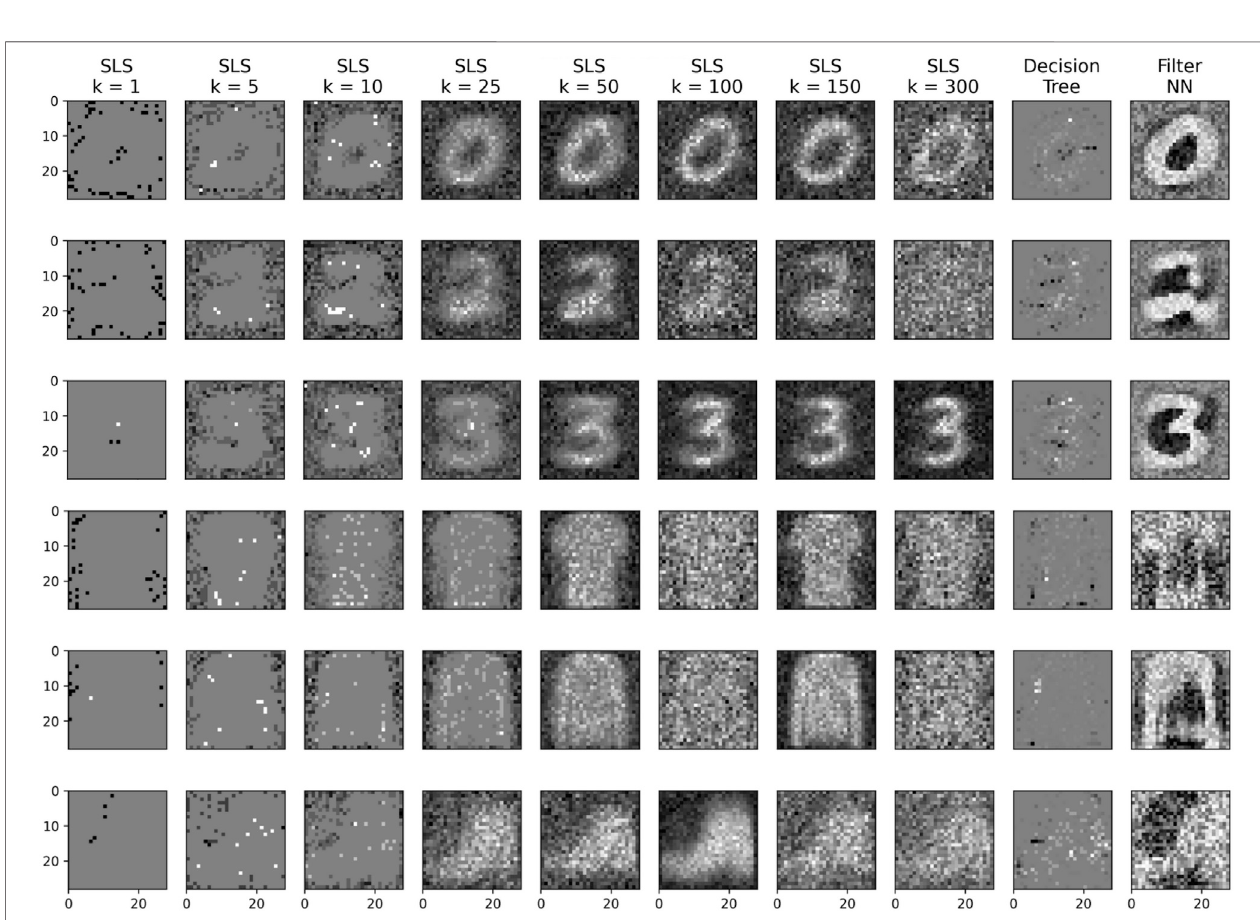
FIGURE 6 | A visualization of the rules learned by the SLS algorithm ( k (cid:2) [ 1 , 5 , 10 , 25 , 50 , 100 , 150 , 300 ] ), decision tree and the fi lter used in the NN. Rows 1 – 3 are the rules for labels [Zero, Two, Three] of the MNIST dataset. Row 4 – 6 are the rules for the labels [T-shirt/Top, Sweater, Ankleboot] of the FASHION-MNIST dataset. For small k ,discriminative rules arelearned,and forlarge k characteristicrules. Inrows 2and 5for k (cid:2) 300itcan beseen howdisjunctions, which werenot further optimized after initialization, overlay the visualization of the optimized disjunctions.